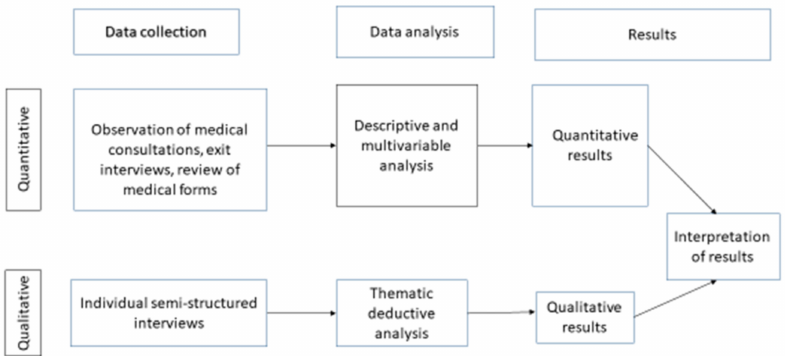
Figure 1. Graphic representation of the convergent parallel study design.